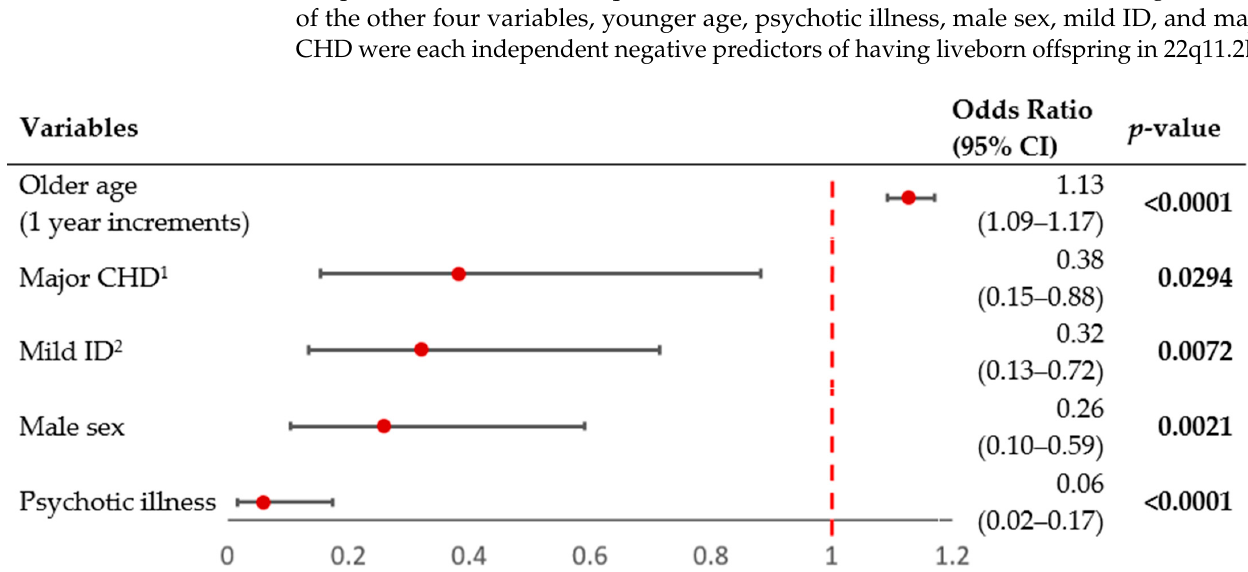
Table 2. Adults with 22q11.2DS ( n = 368) comparing those with ( n = 51) and without ( n = 317) liveborn offspring.